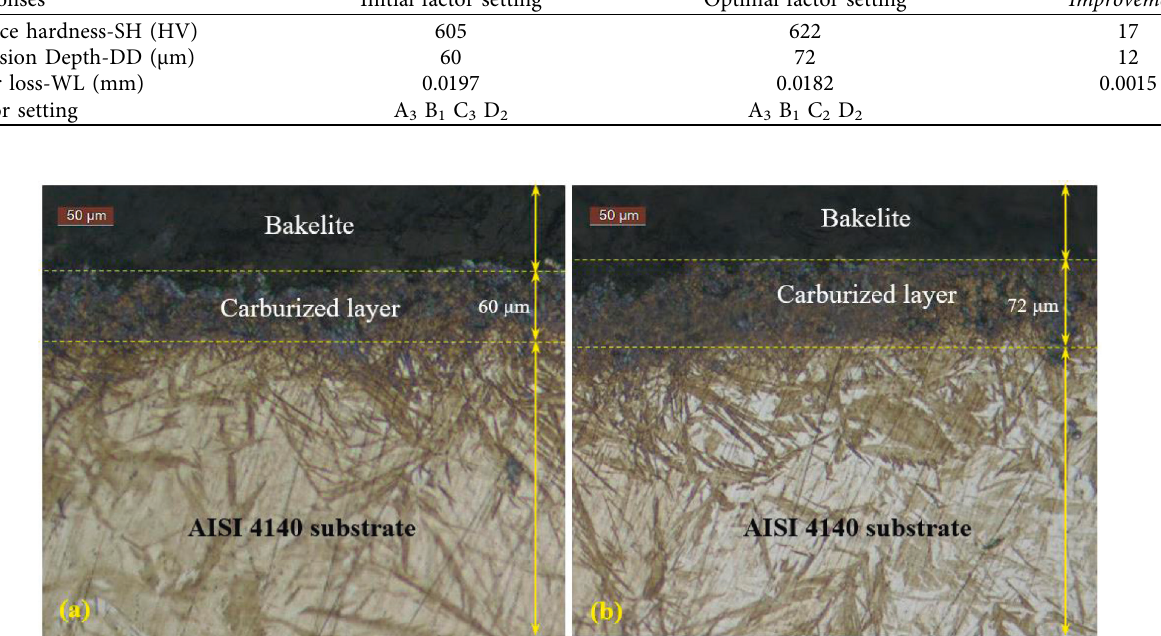
Figure 7: SEM image of carburized surface displaying diffusion depth for (a) initial setting-60 μ m and (b) GIBT setting-72 μ